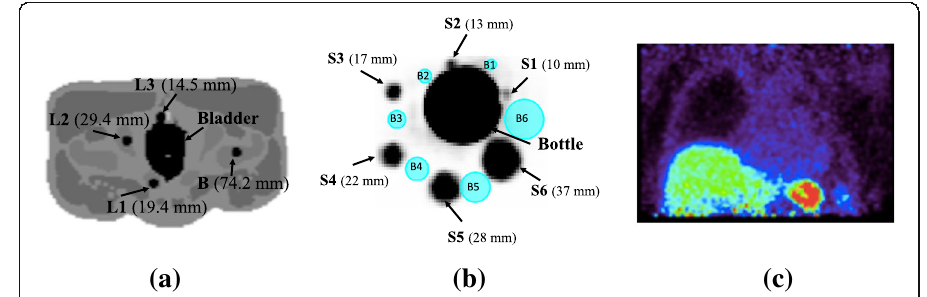
Fig. 1 The datasets used for this study: a simulation from XCAT2 phantom consisting of the bladder, three lesions (L1 – L3) and one background lesion (B) placed at different distances (shown in brackets) from the bladder; b NEMA phantom consisting of a hot bottle at the centre, surrounded by six spheres (S1 – S6) with diameters shown in brackets. The blue spheres (B1 – B6) were used to estimate the background activity for the estimation of contrast-to-noise ratio (CNR); c patient data showing high activity in the spleen and